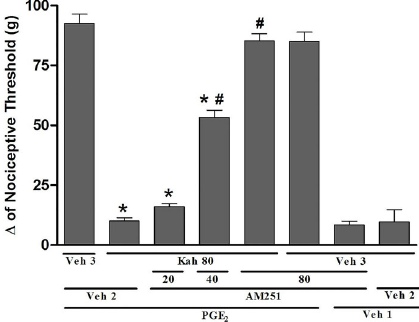
Figure 3. The CB 1 receptor antagonist blocked kahweol-induced peripheral antinociception in hyperalgesic paws. The antinoci- ceptive response was measured by the paw pressure test. Prostaglandin E 2 (PGE 2 ) injection (2 m g/paw) was done at time 0, AM251 (20, 40, 80 m g/paw) was injected at time 165 min, and kahweol (Kah; 80 m g/paw) was given at 175 min. Measurements were made prior to and 180 min after PGE 2 administration. Data are reported as means ± SE (n=5) of D nociceptive threshold measured in grams (g). *P o 0.05 compared to PGE 2 + Veh 2 + Veh 3; # P o 0.05 compared to PGE 2 + Veh 2 + Kah 80)-injected groups (ANOVA and Bonferroni ’ s test). Veh (vehicle) 1: 2% ethanol in saline; Veh 2: 10% DMSO in saline; Veh 3: sterile saline solution (0.9% NaCl).